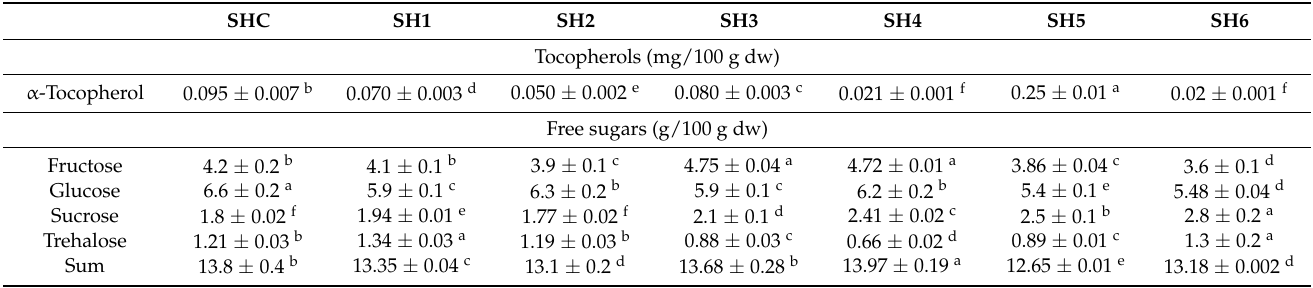
Table 5. Tocopherol (mg/100 g dw) and free sugar (g/100 g dw) content in S. hispanicus leaves in relation to fertigation regime (mean ±